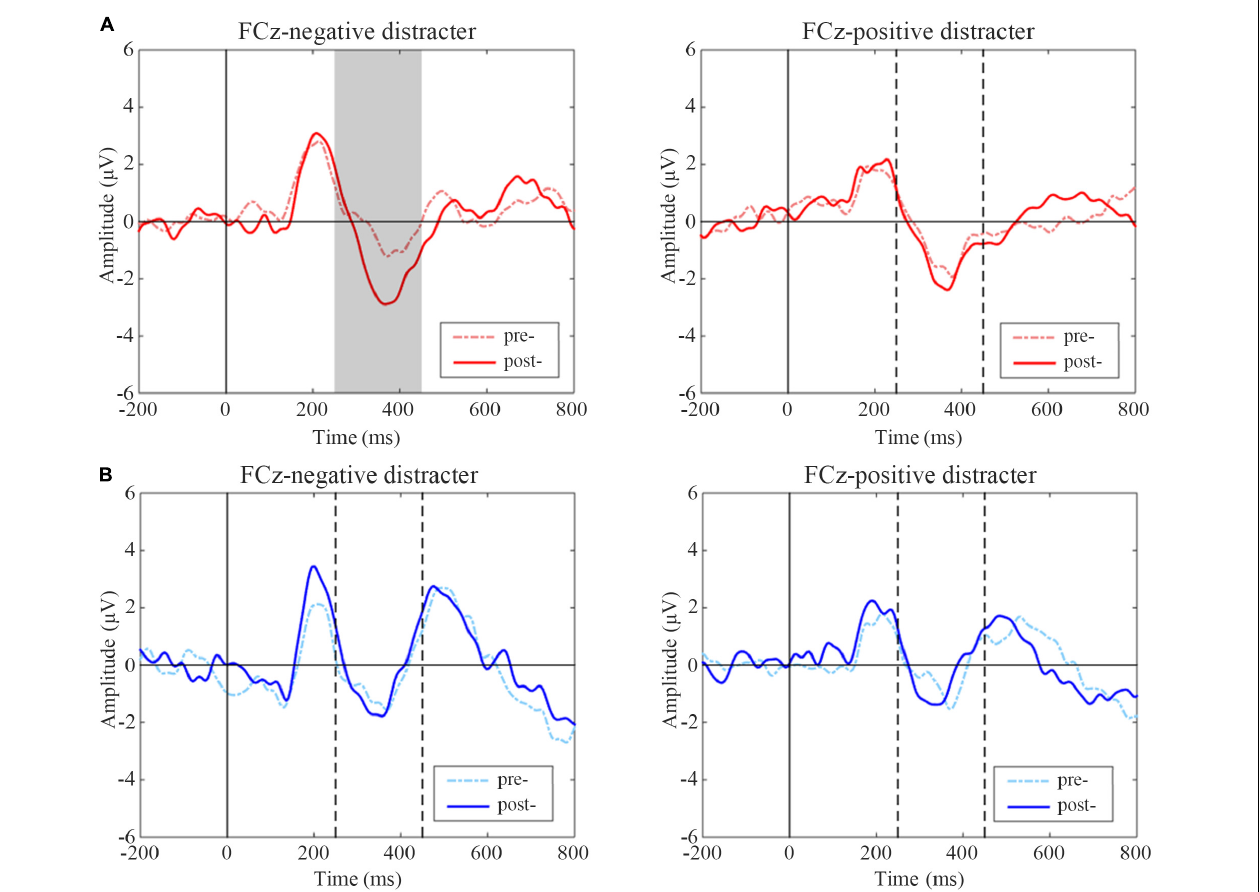
FIGURE 6 | Event-related potentials (ERP) difference waves of pre- and post-treatment tests for negative and positive distracters in two groups. (A) Active group, (B) Sham group. The gray-filled area indicates the period with a significant difference and the gray dotted lines indicate the time points at 250 and 450 ms.